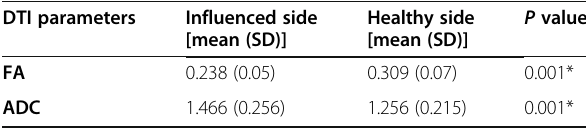
Table 1 Diffusion tensor imaging findings in the included patients